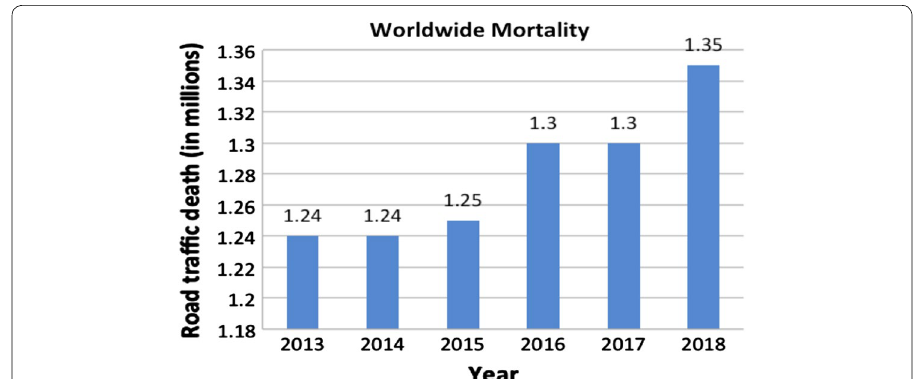
Fig. 2 Number of deaths year wise in road